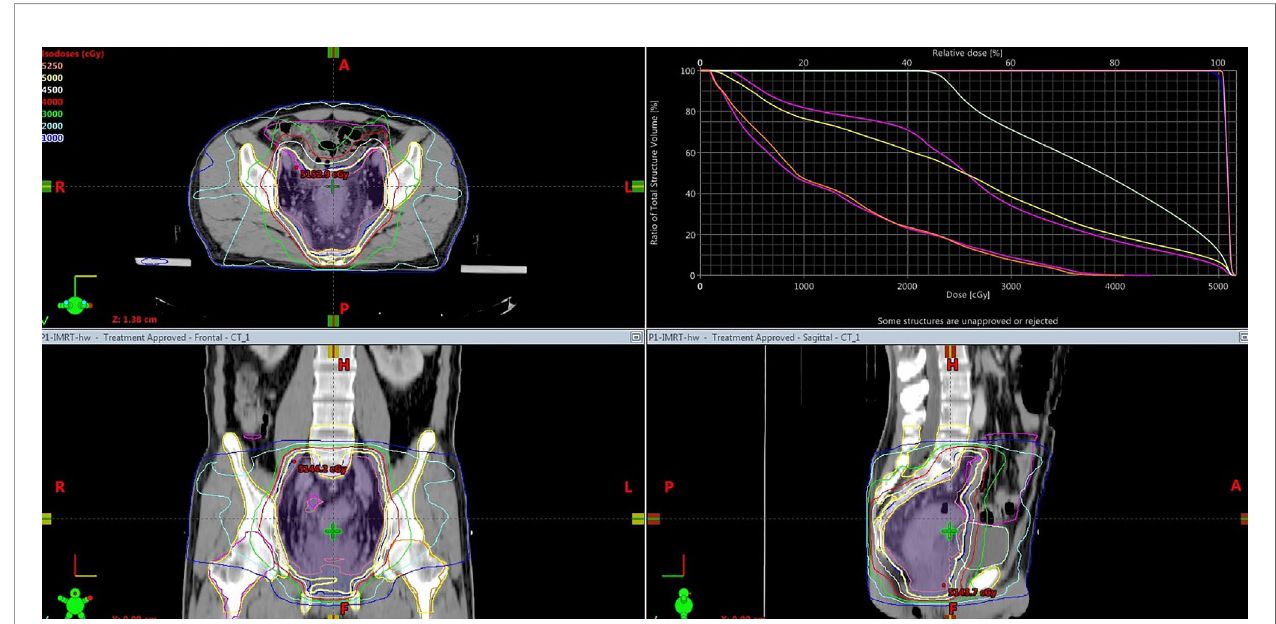
FIGURE 2 | Dose distribution (isodose line) and dose volume histogram of a representative PBM sparing 7 fi xed- fi eld IMRT plan. The dose prescription for this case was